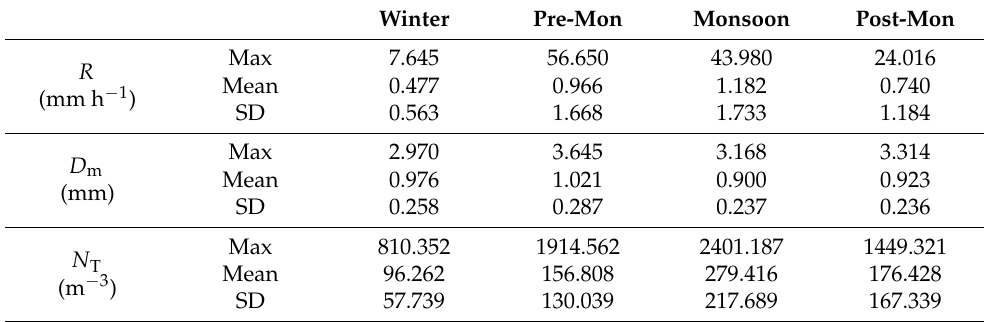
Table 3. Maximum, mean and standard deviation of R , D m and N T during the four seasons. Winter Pre-Mon Monsoon